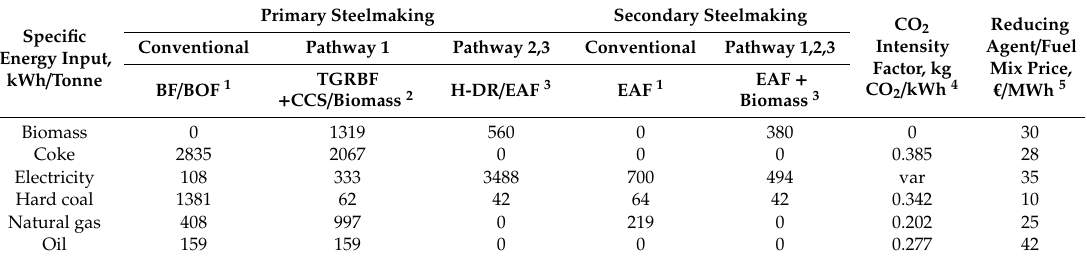
Table A1. Specific energy consumption per tonne of steel, CO 2 emission factors and price of reducing agent and fuel mix applied in the investigated pathways.